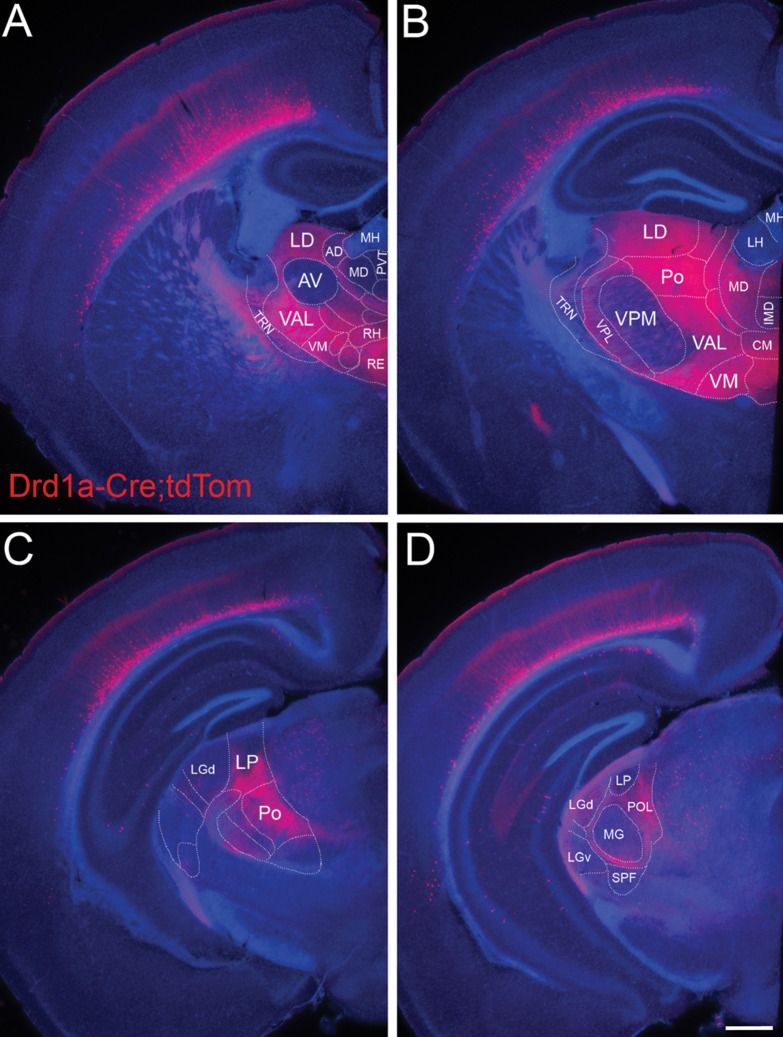

Projections from Drd1a-Cre::tdTom L6b neurons target second-order and avoid first-order thalamic nuclei. In adult (P35) brains, labeling of Drd1a-Cre::tdTom+ fibers derived from the entire cortical mantle reveals that layer 6b neurons target higher order thalamic nuclei while avoiding relay thalamic nuclei. (A) Projections from layer 6b avoid anterior ventral nucleus (AV) as well as the habenula and paraventricular thalamic nucleus, whereas higher order nuclei such as lateral dorsal (LD) or ventral anterior lateral (VAL) and ventral medial (VM) are densely filled with terminal branches. Note that within cortex, the majority of processes from L6b end below L4 in barrel cortex, except for a dense band of branched fibers in the marginal zone. (B) Layer 6b projections also largely avoid ventral-posterior-medial (VPM) but densely branch in posterior nucleus (Po). Fibers pass through TRN and ventral-posterior lateral nucleus (VPL) without apparent branching. Some midline nuclei such as central medial (CM) are innervated whereas others are not. (C) Fibers from layer 6b also avoid the first-order visual thalamic nucleus (lateral geniculate nucleus—LGd) anteriorly but target the higher order visual nucleus lateral posterior (LP), and a small region of posterior LGd (D). (D) Fibers from layer 6b bypass the first-order auditory nucleus (medial geniculate nucleus) in the thalamus. Note the scattered tdTom+ cells in the midbrain, including superior colliculus and anterior pretectal nucleus visible at this level. Scale bar = 500 μm. AD, anterodorsal nucleus; AV, anteroventral nucleus; CM, central medial nucleus; IMD, intermediodorsal nucleus; LD, lateral dorsal nucleus; LH, lateral habenula; LGd, dorsal lateral geniculate nucleus; LGv, ventral lateral geniculate nucleus; LP, lateral posterior nucleus; MD, mediodorsal nucleus; MG, medial geniculate nucleus; MH, medial habenula; Po, posterior nucleus; POL, posterior limiting nucleus; PVT, paraventricular nucleus; RE, nucleus reuniens; RH, rhomboid nulceus; SPF, subparafascicular nucleus; TRN, (pre-)thalamic reticular nucleus; VAL, ventral anterior lateral complex; VM, ventral medial nucleus; VPL, ventral-posterior lateral nucleus; VPM, ventral-posterior medial nucleus.